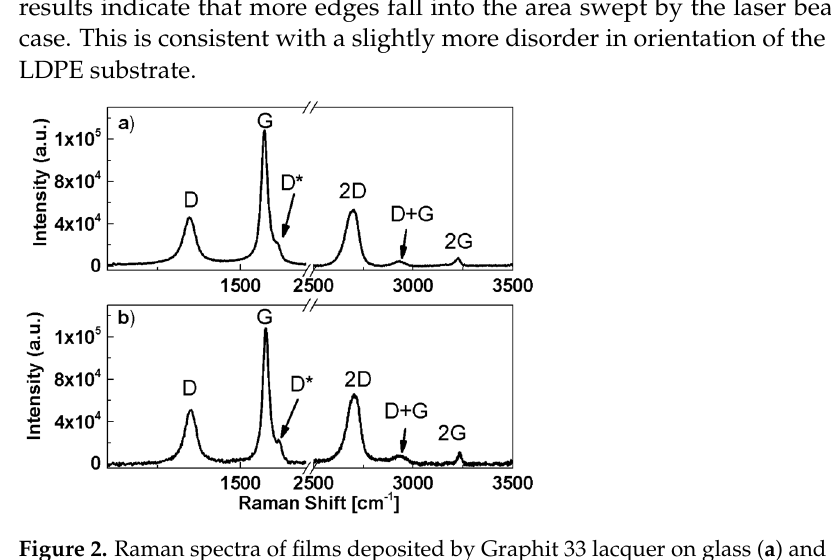
Figure 2. Raman spectra of films deposited by Graphit 33 lacquer on glass ( a ) and LDPE ( b ).